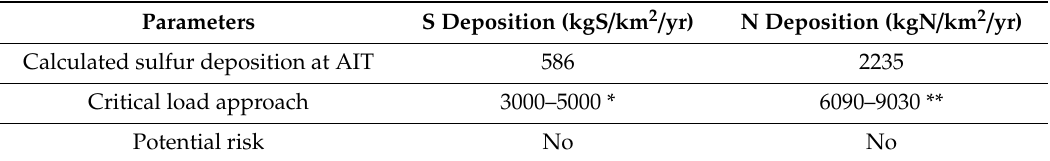
Table 4. Current sulfur and nitrogen deposition in Pathumthani Province compared to the critical load values. Source: Mettasitthikorn, 2017 (see